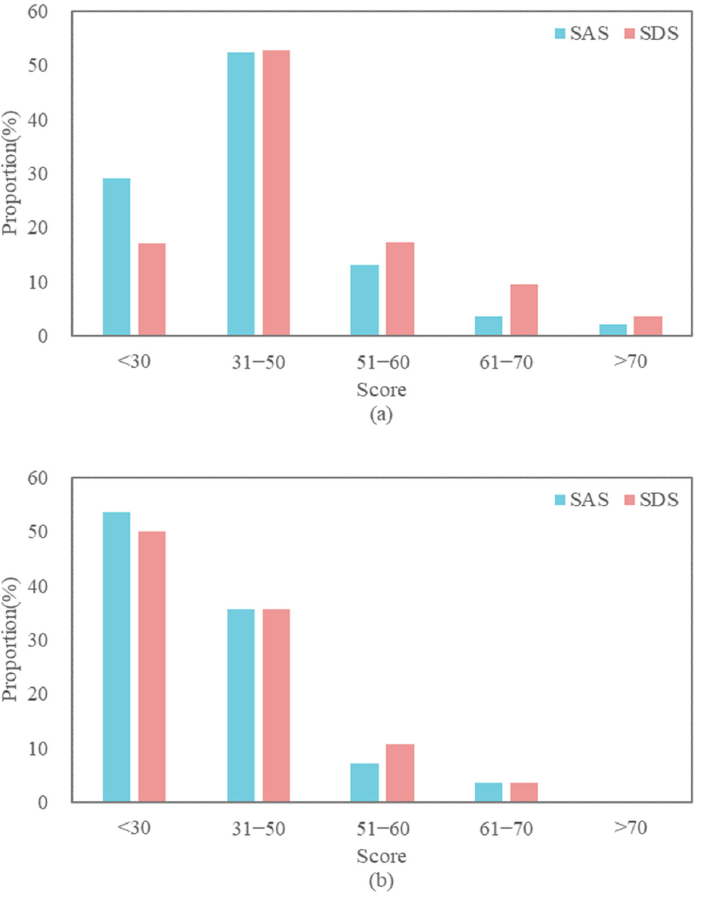
Figure 5. SAS and SDS score distribution of ( a ) isolated and ( b ) free-moving